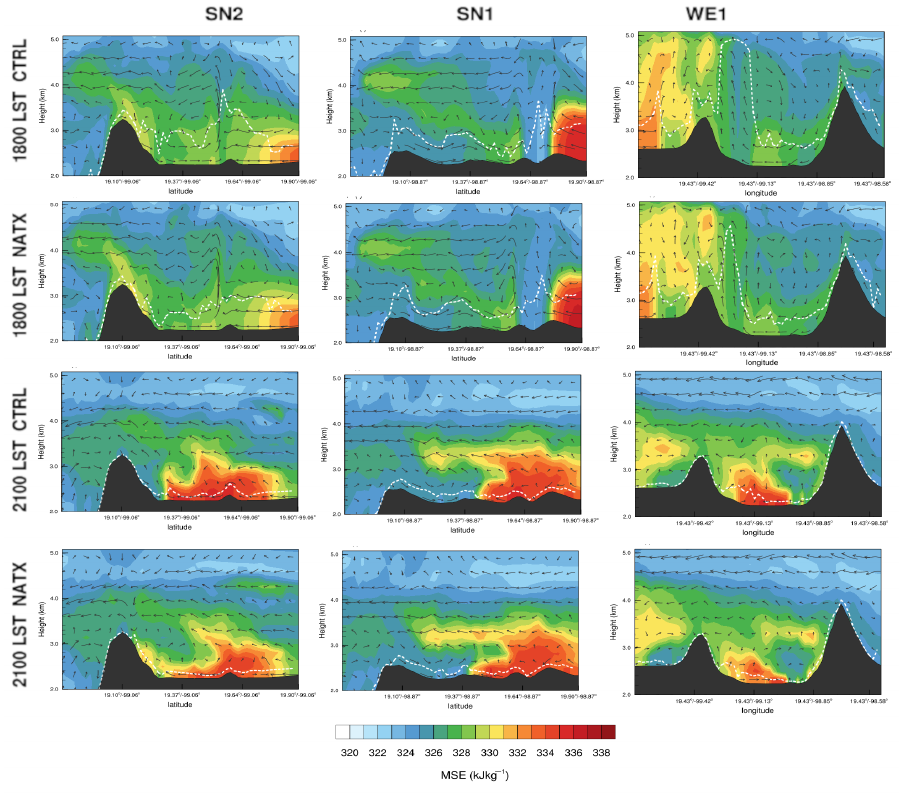
Figure 8. Same as Figure 7 except for hours 1800, and 2100